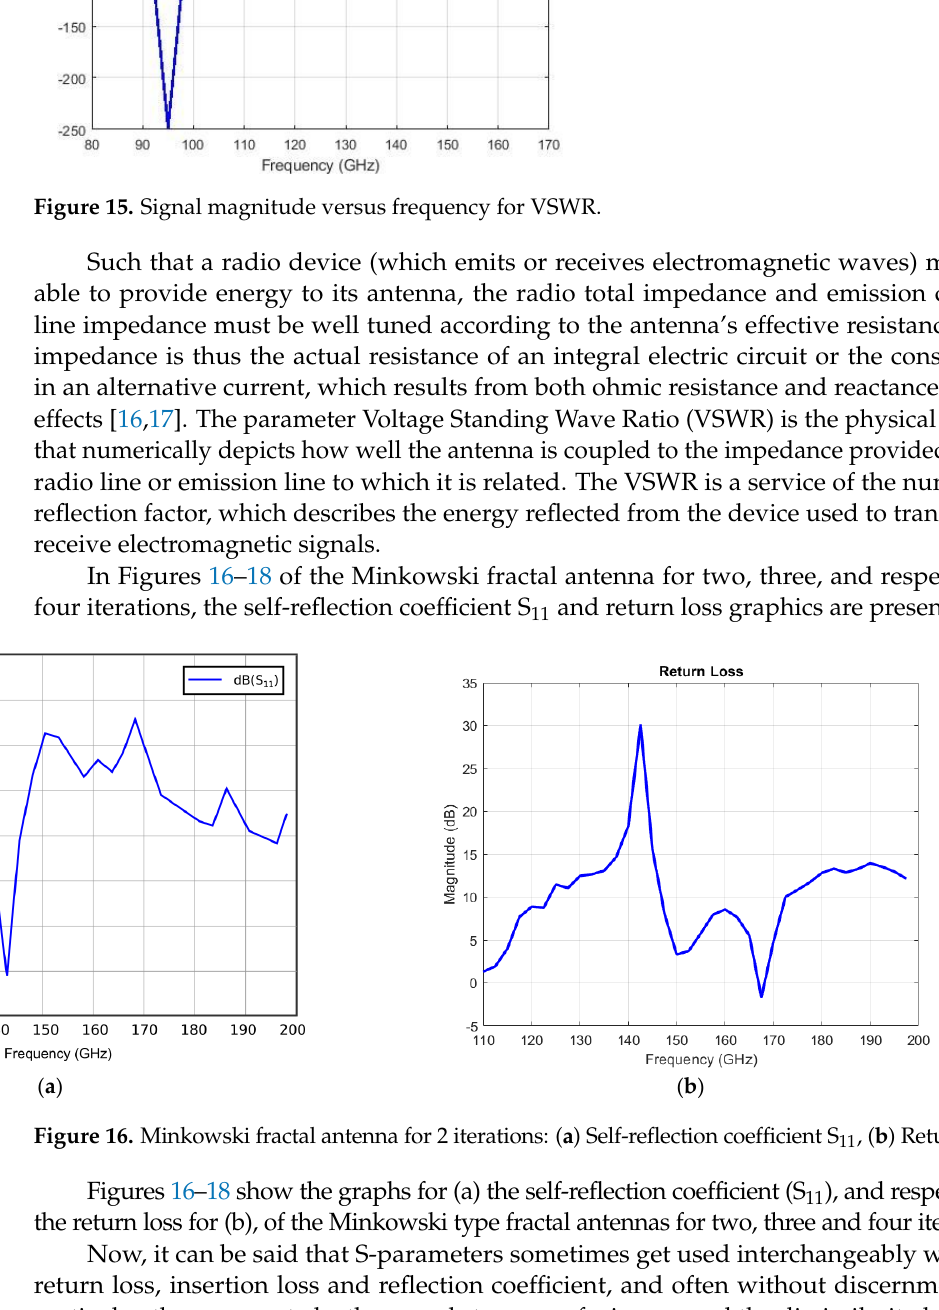
Figure 15. Signal magnitude versus frequency for VSWR.